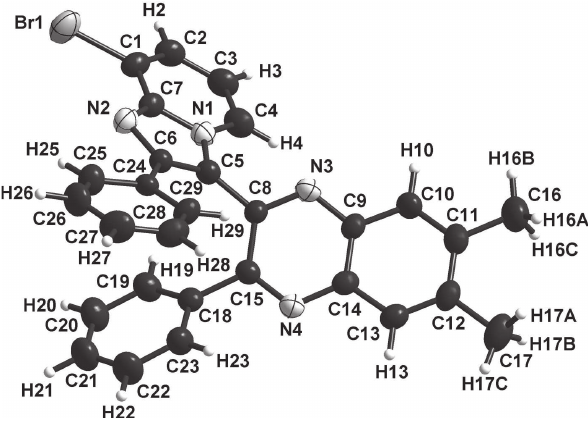
Table 1: Data collection and